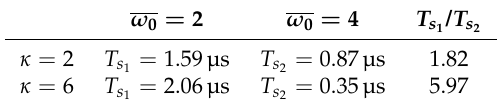
Table 4. Improvement in settling time achieved by doubling the value of ω 0 at different values of κ